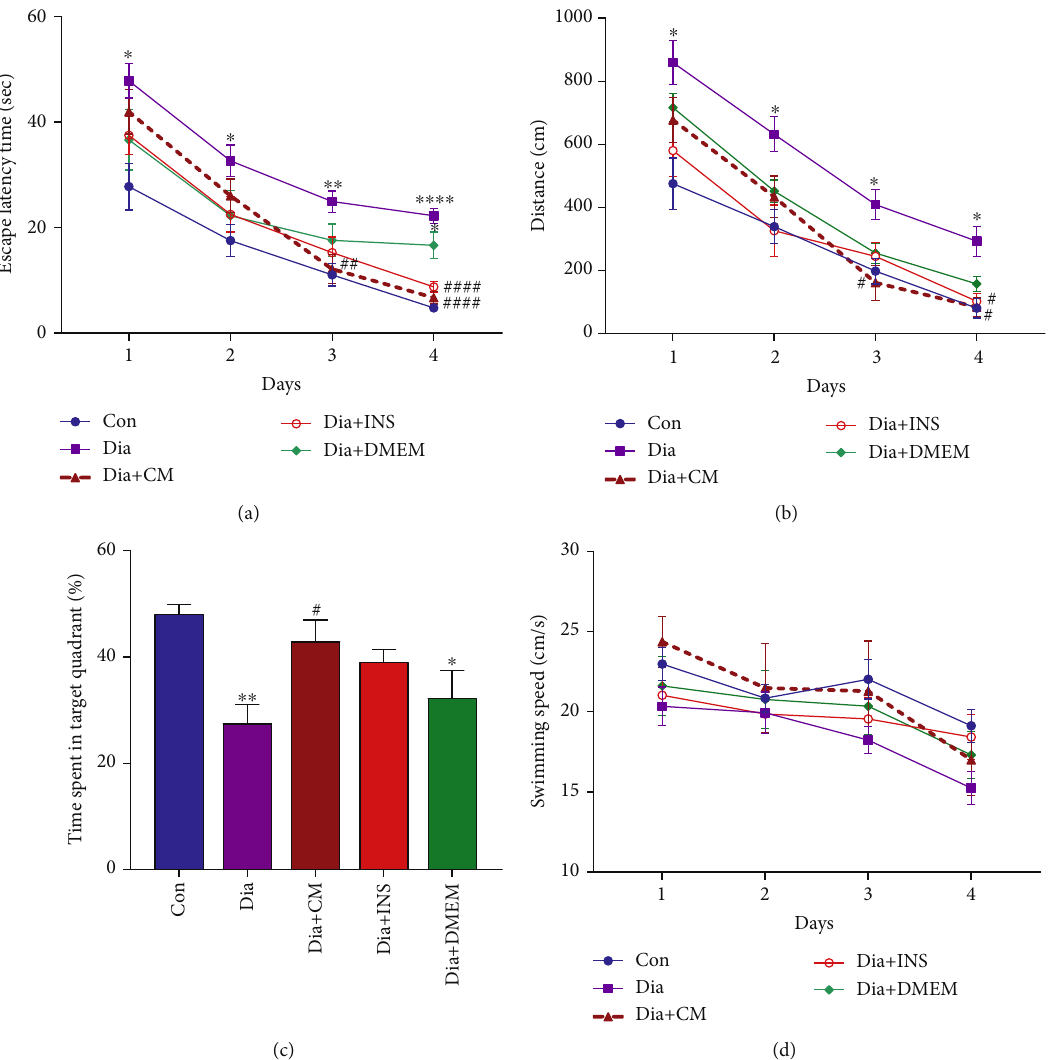
Figure 4: E ff ects of WJMSC-CM and insulin on spatial learning and memory in the Morris water maze in diabetic rats. The administration of WJMSC-CM improved the spatial learning performance in diabetic rats and signi fi cantly decreased the escape latency time (a) and traveled distance (b) on days 3 and 4. Using insulin improved spatial learning only on day 4 (two-way ANOVA). In the probe trial, after the removal of the platform, the percentage of target quadrant time (c) was signi fi cantly increased in Dia +CM group. The values are presented as mean ± SEM ( n = 7 ). Signi fi cant di ff erences versus the control ( ∗ P < 0 : 05 , ∗∗ P < 0 : 01 , ∗∗∗ P < 0 : 001 , ∗∗∗∗ P < 0 : 0001 ) and diabetes rats ( # P < 0.05, ## P < 0.01, #### P < 0.0001). Con: control; Dia: diabetes; Dia +CM: WJMSC-CM-treated diabetic group; Dia + INS: insulin-treated diabetic group; Dia +DMEM: DMEM-treated diabetic grooming (Figure 5(c)) in WJMSC-CM- and insulin-treated groups were higher than in the untreated diabetic group.